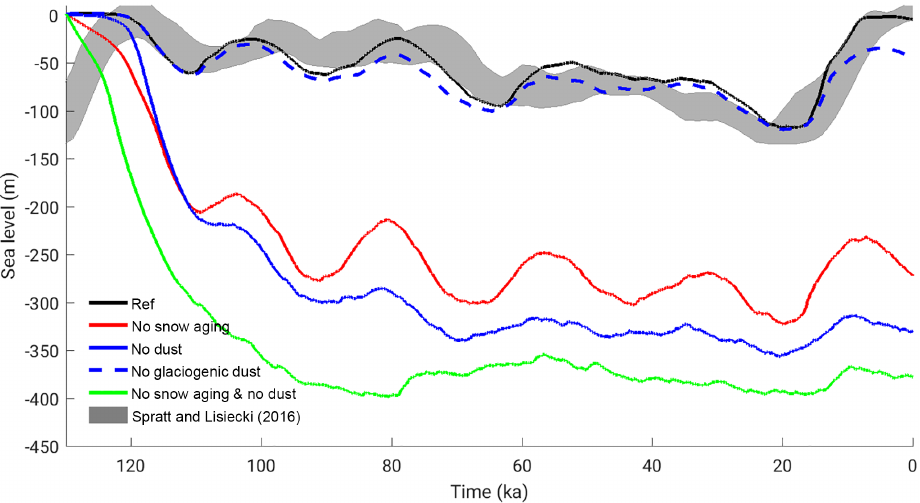
Figure 7. Effect of snow aging and dust deposition on modelled sea level over the last glacial cycle for different online experiments as indicated in the legend.